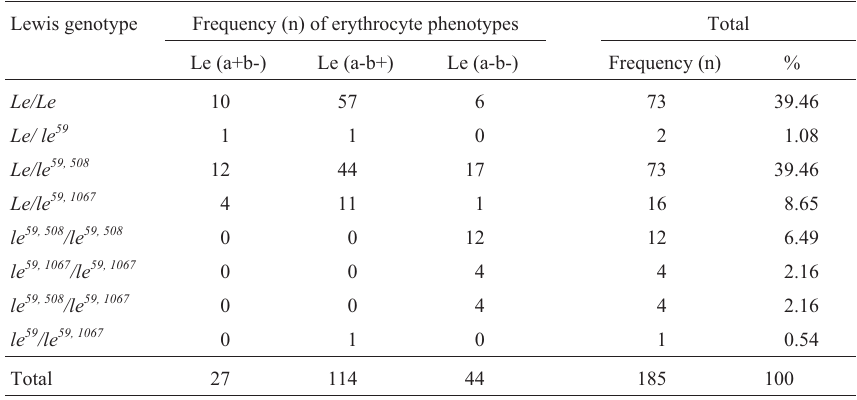
Table 3 - Association between the FUT3 gene SNP genotype frequencies and the Lewis ( Le ) erythrocyte phenotypes for a sample population (n = 185) of Brazilians of Japanese ancestry. The le 59 genotype represents the 59G allele while le 59,508 represents the association of the 59G and 508A alleles on the same chromosome and le 59, 1067 the association of the 59G and 1067A alleles on the same